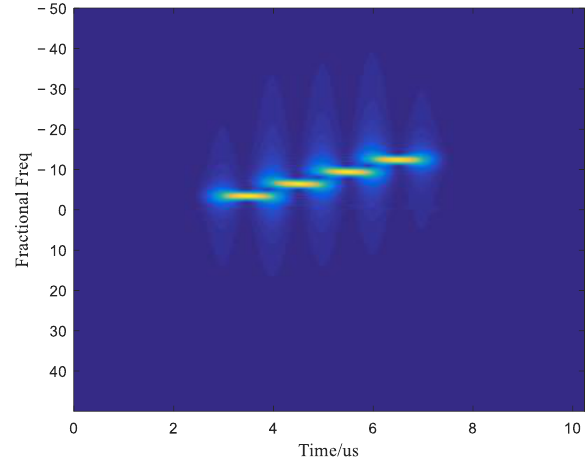
Figure 4. STFRFT spectrogram of a 4-slices jamming.